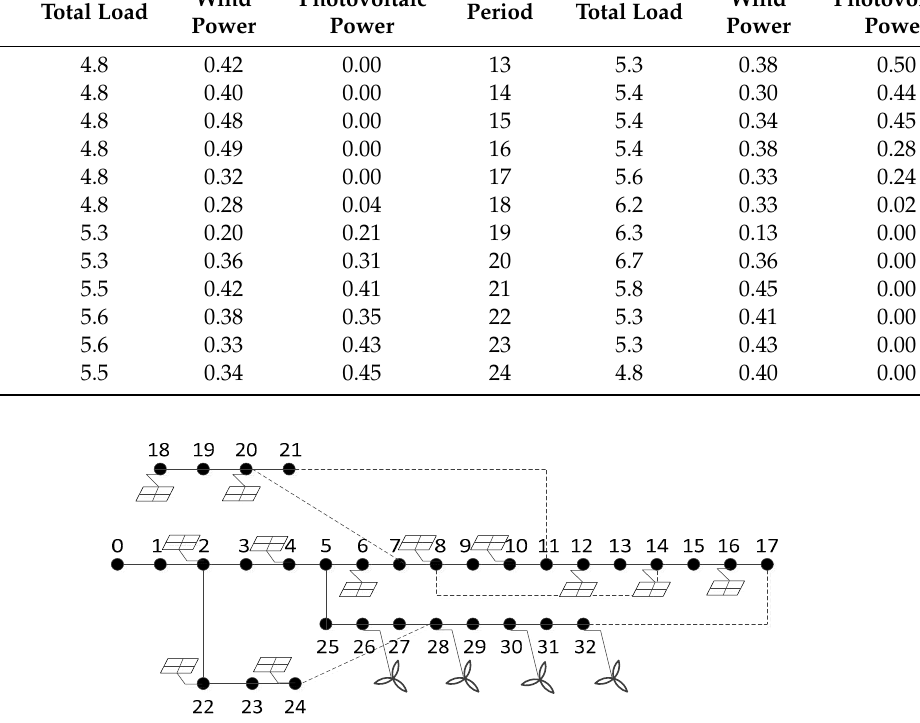
Table 4. Optimized Configuration Results. 457